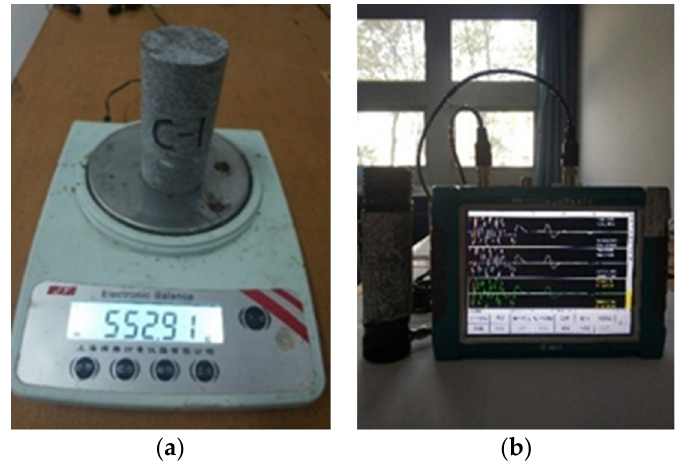
Figure 2. Major test steps. ( a ) Test block weighing. ( b ) Test block wave velocity